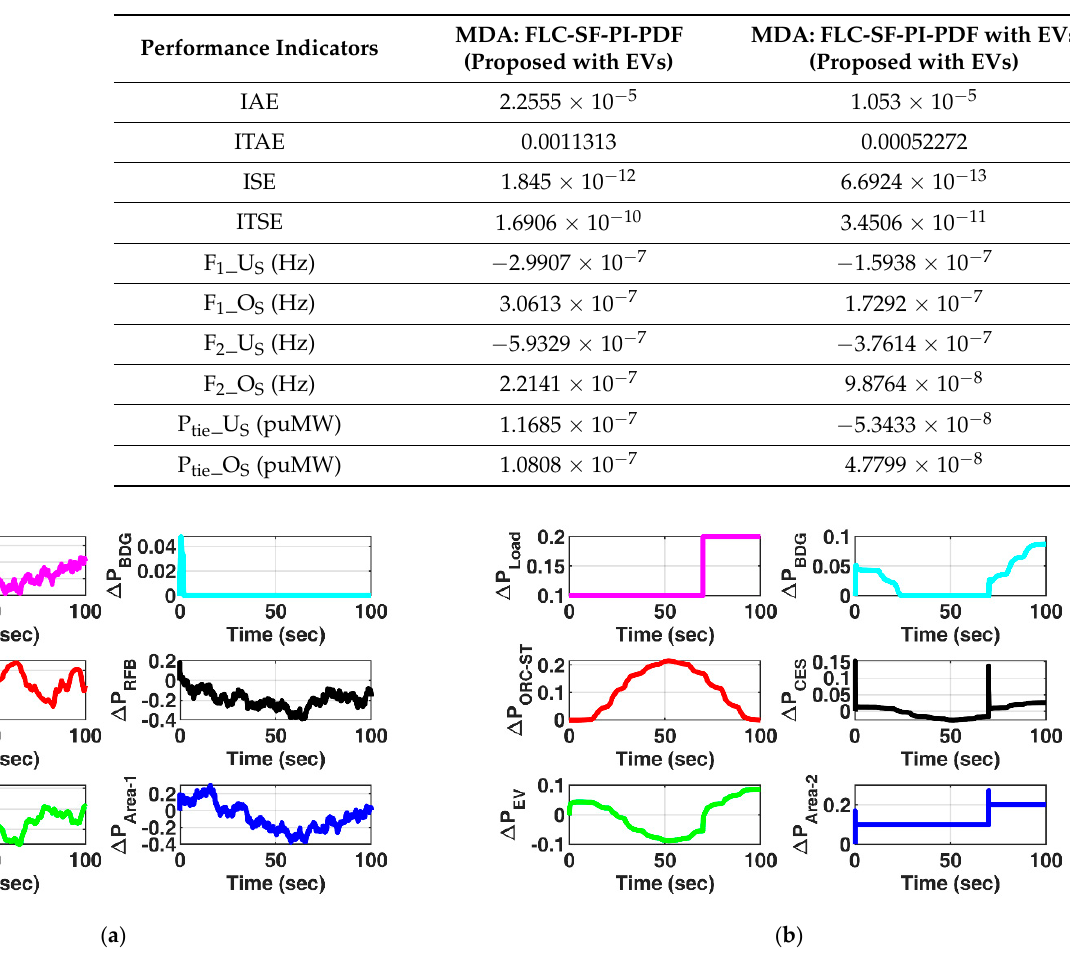
Figure 12. ( a ) Power response of microgrid components of area 1. ( b ) Power response of MG com- ponents of area 2. Table 4. Performance indices with random load and inputs of renewable sources input